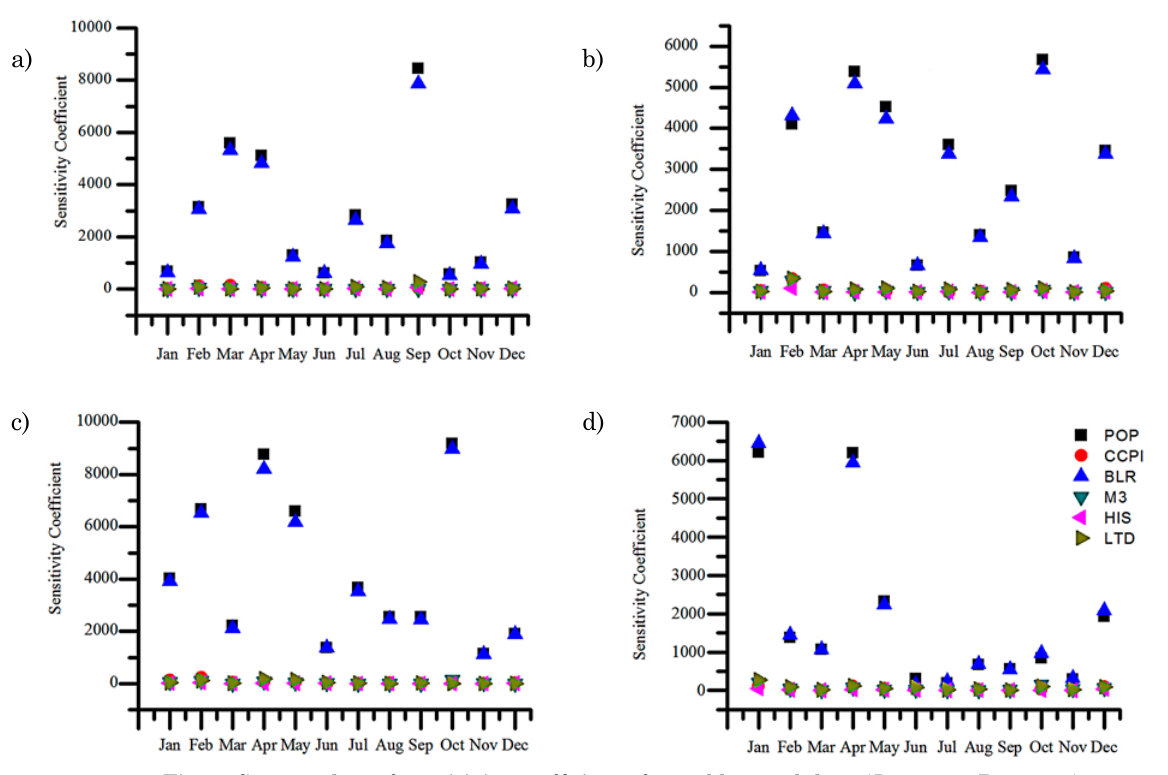
Fig. 8. Scatter plots of sensitivity coefficients for stable trend data (Jan 2010–Dec 2010)